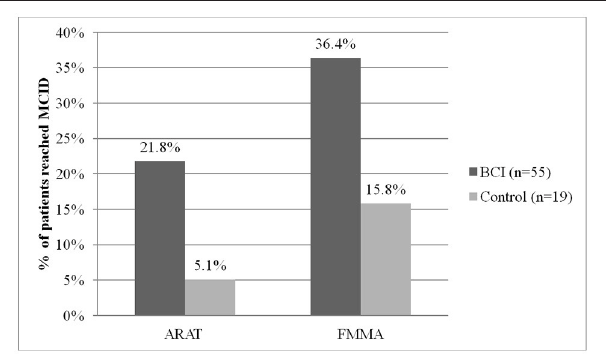
FIGURE 3 | Percent of patients reached minimal clinically important difference (MCID) by ARAT and FMMA scores in each study group.